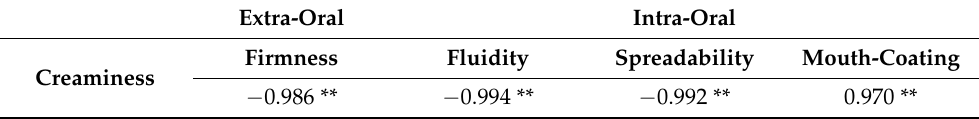
Table 4. Correlation between creaminess and instrumental texture parameters/viscosities at differ- ent shear rates.